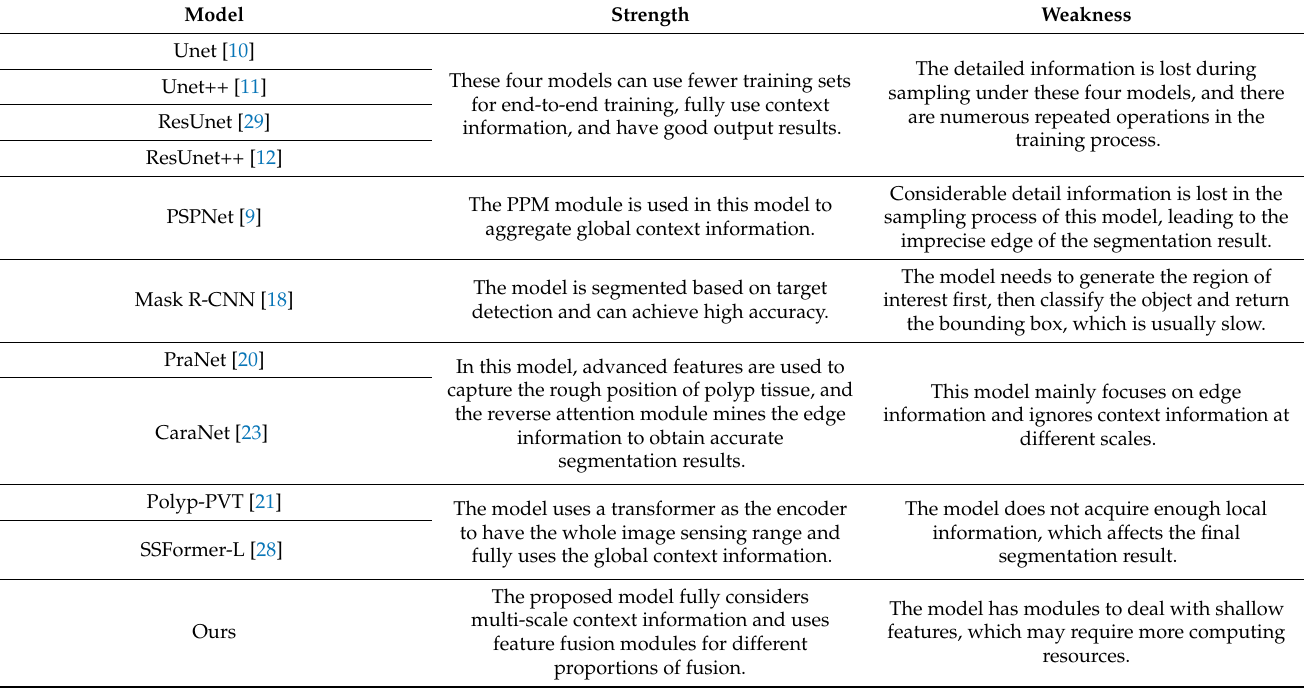
Table 1. Strengths and weaknesses of common models and models proposed in this